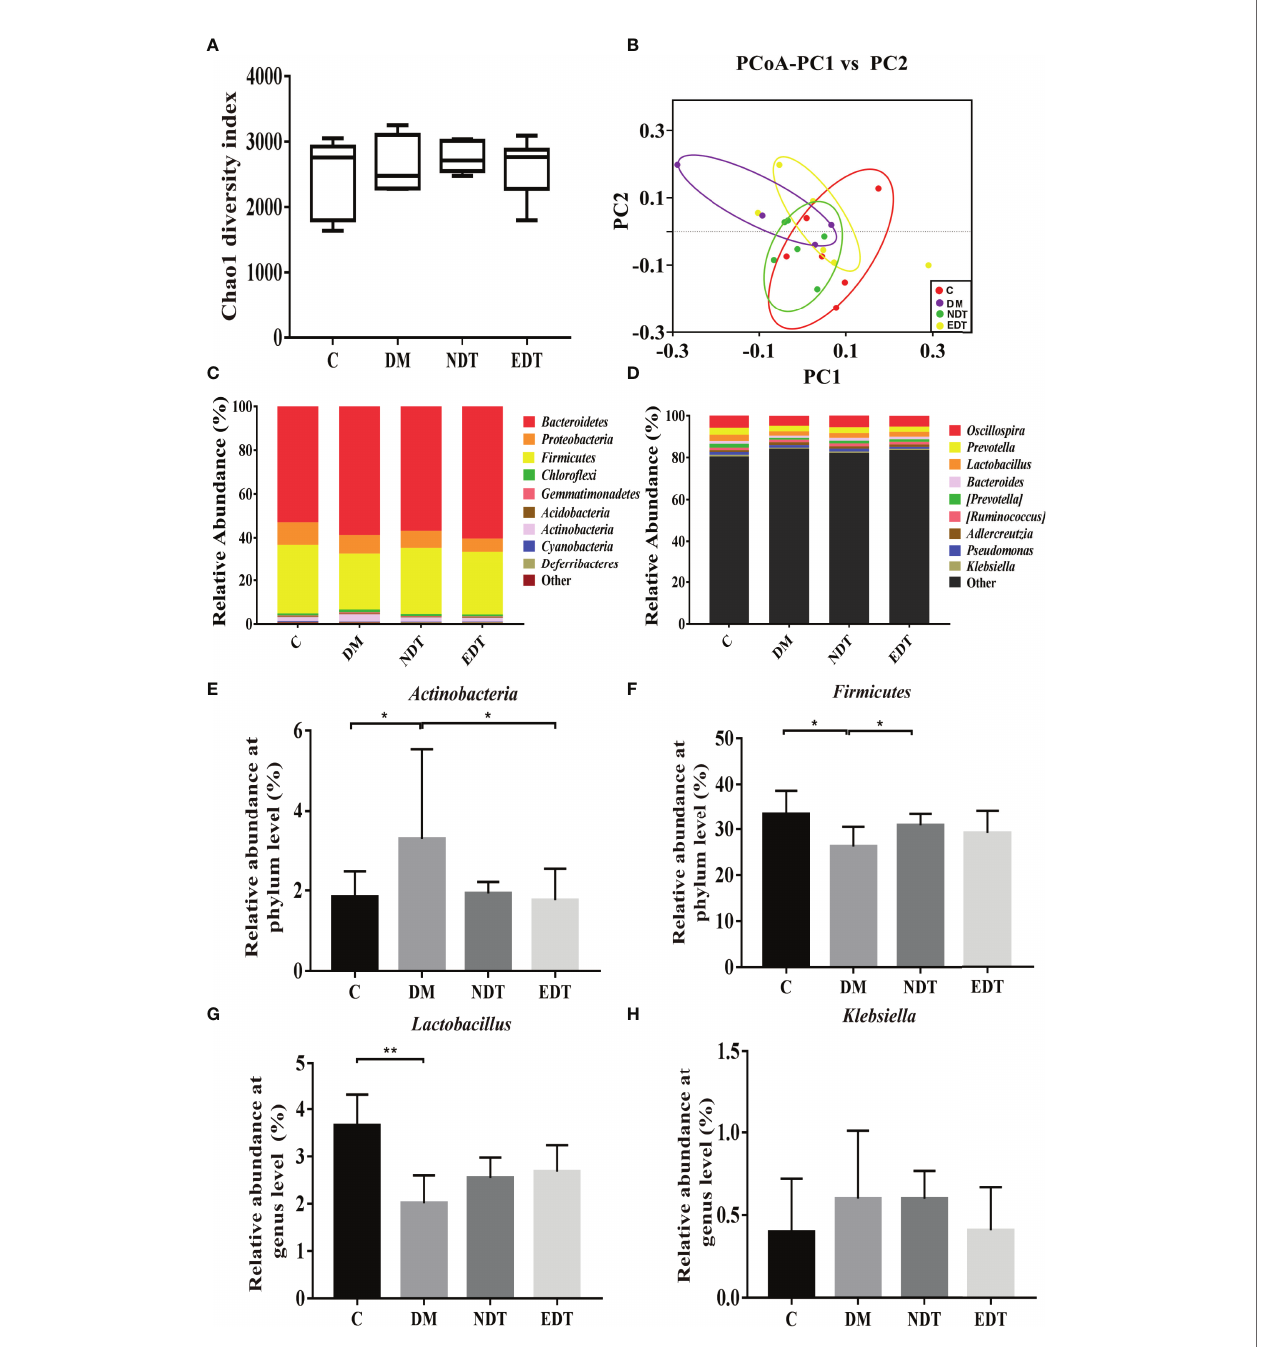
FIGURE 6 | Effects of L. crispatus -pMG36e-mCXCL12 on vaginal microbiota in intrauterine adhesion mice with diabetes. Evaluation of the effect of L. crispatus - pMG36e-mCXCL12 on vaginal microbiota of intrauterine adhesion mice with diabetes using (A) the Chao1 Diversity, (B) the PCoA of the b diversity index, the relative abundance (C) at the phylum level and (D) at the genus level. Evaluation of the effect of L. crispatus -pMG36e-mCXCL12 on the relative abundances of the phyla (E) Firmicutes , (F) Actinobacteria in intrauterine adhesion mice with diabetes; Evaluation of the effect of L. crispatus -pMG36e-mCXCL12 on the relative abundances of the genera (G) Lactobacillus , (H) Klebsiella in intrauterine adhesion mice with diabetes. C group, Control group; DM group, laparotomy was used to construct a model of intrauterine adhesion mice with diabetes; NDT group was treated with L. crispatus for intrauterine adhesion mice with diabetes; EDT group was treated with L. crispatus -pMG36e-mCXCL12 for intrauterine adhesion mice with diabetes. Unpaired t-test was used for statistical analysis and all data are presented as mean ± standard deviation (SD). ns, P > 0.05; *P < 0.05; **P <